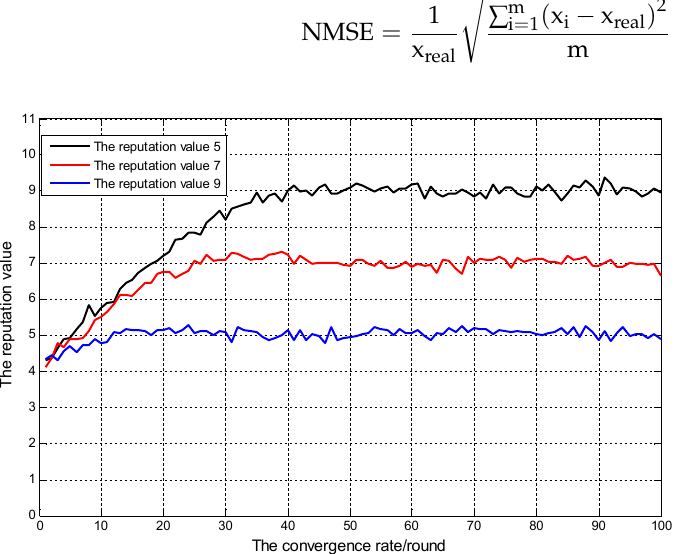
Figure 7. The average convergence speed with real reputation values of 5, 7 and 9.